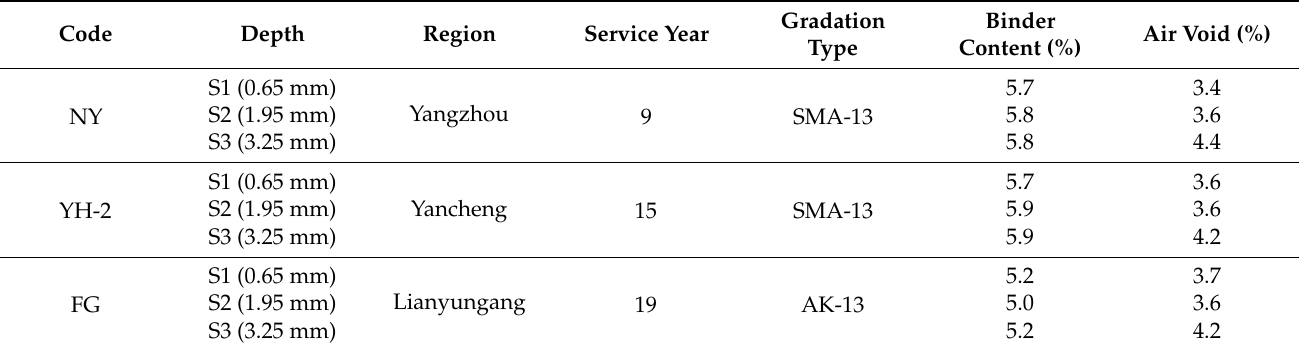
Table 1. Summary of field cores from different highway sections.